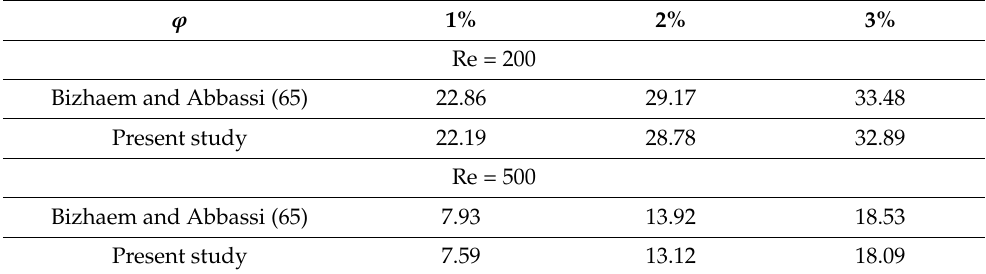
Table 3. Proposed model versus the method of Bizhaem and Abbasi